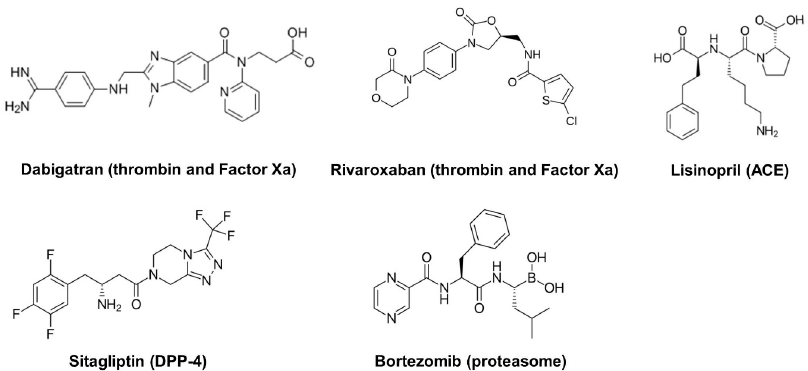
Figure 2. Examples of commercially available protease inhibitors and their targets. Dabigatran and Rivaroxaban are anti-coagulants; Lisinopril is for hypertension; Sitagliptin is for diabetes; and Bortezomib is for multiple myeloma.